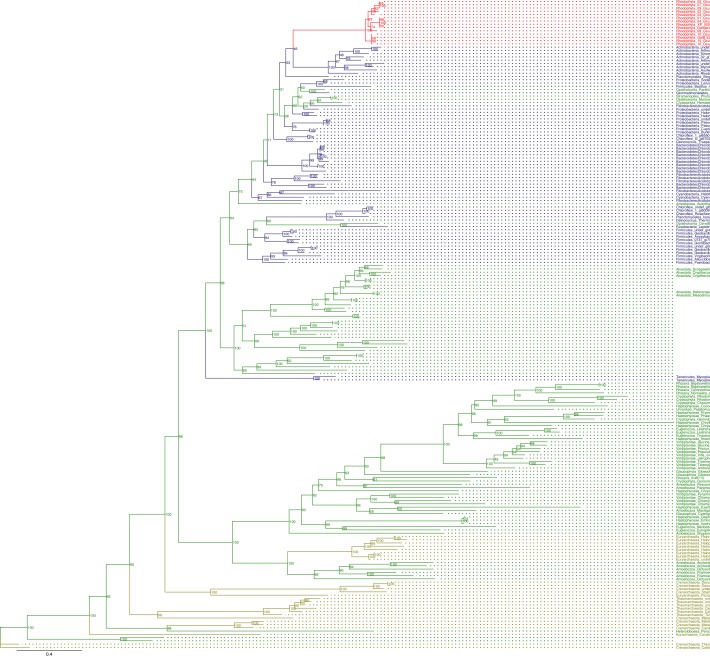
Sequence tree of orthogroup OG0002337.The tree is based on amino acid sequences. Archaea (yellow), Bacteria (blue), Cyanidiales (red), Eukaryotes including other red algae (green). Branches containing Cyanidiales sequences are highlited in red.